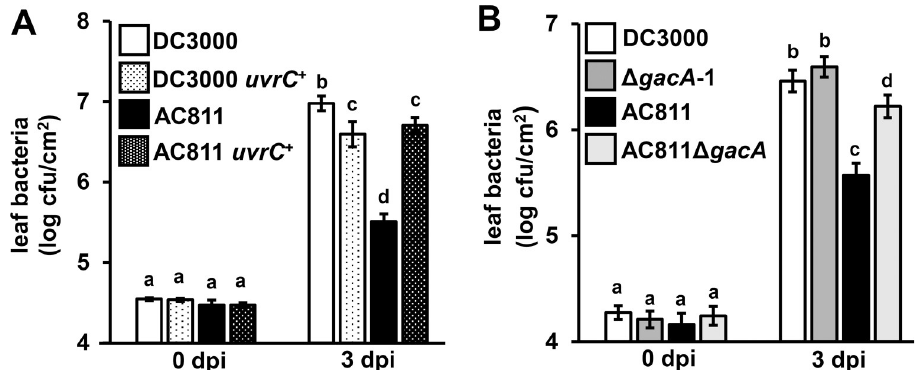
Fig 3. Growth of AC811 in Arabidopsis is enhanced by eliminating polar effects of Tn 5 :: gacA insertion on uvrC expression. (A) Arabidopsis leaves were syringe-infiltrated with DC3000 or AC811 carrying either pME6010 empty vector or pME6010:: uvrC as indicated. Graphed are means ± SE of leaf bacteria measured by serial dilution plating; n = 9. Data are pooled from three independent experiments. (B) Arabidopsis leaves were syringe infiltrated with DC3000 WT, AC811, Δ gacA -1 or AC811 Δ gacA . Graphed are means ± SE of leaf bacteria measured by serial dilution plating; n = 14. Abbreviation dpi is days post-infection. Data are pooled from four independent experiments. Small- case letters in (A) and (B) denote statistical groups determined by ANOVA with multiple pairwise t -test comparisons and Tukey’s post-hoc HSD analysis, p < 0.05.